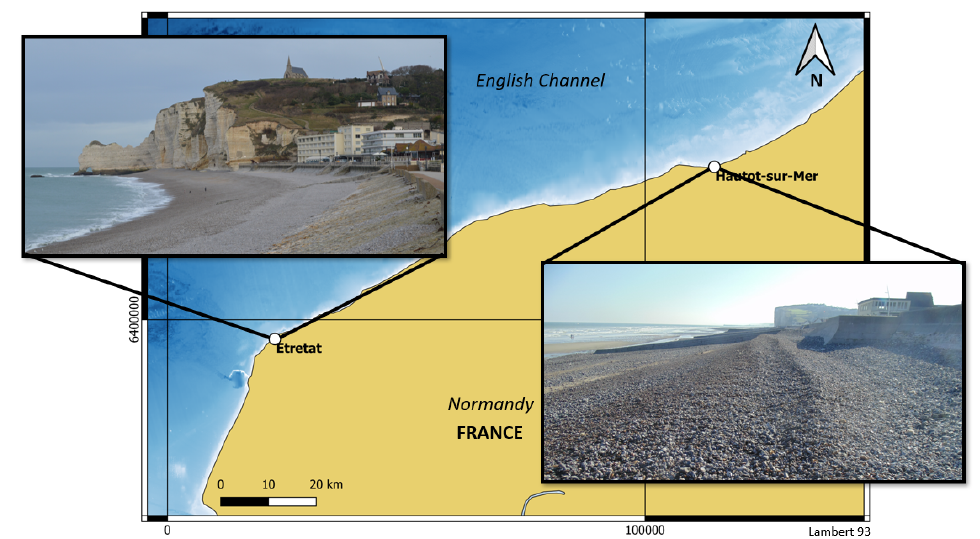
Figure 5. Location and pictures of the two pebble beaches of Etretat and Hautot-sur-Mer.